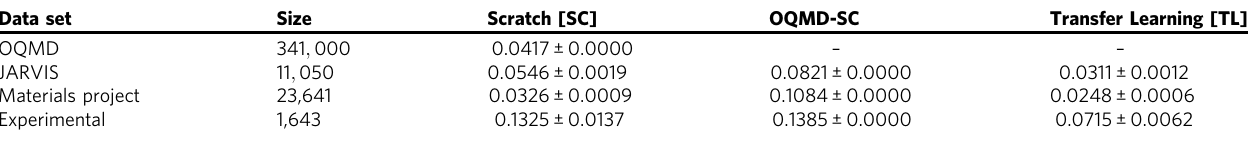
Table 1 Performance of the ElemNet models from 10-fold cross-validation in MAE (eV/atom). Data